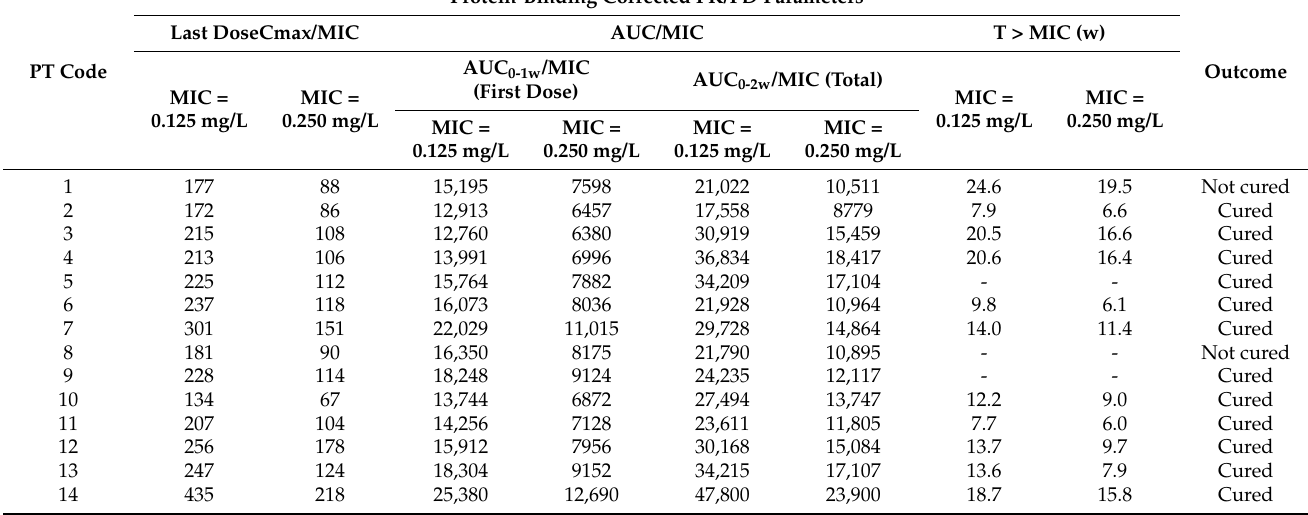
(-) indicates missing data due to insufficient PK follow-up. Considering the breakpoint MIC for staphylococci and streptococci (0.125 mg/L) and the effect of 93% plasma protein binding, mean PK results showed cumulative AUC 0-1w /MIC, AUC 0-2w /MIC, and AUC 0- ∞ /MIC ratios of 16,246, 19,959, and 30,608 for the single dose and 18,422, 32,481, and 65,059 for the dual dose, respectively. Patients’ specific AUC/MIC data are summarized in Table 4: all the AUC 0-2w /MIC values surpassed a previously suggested cut-off of 1000 (for staphylococci) [7] of at least 8 folds, even consid- ering the highest breakpoint MIC. Taking into account the 0.125 mg/L breakpoint MIC, the median T > MIC values from the two groups ranged from 11.9 w (IQR 9.3–16.7) to 13.7 w (IQR 12.6–18.8) for the single and dual dose groups, respectively; these values changed to 9.0 w (IQR 6.5–13.4) and 9.7 w (IQR 8.2–14.7) if the general breakpoint of 0.250 mg/L was